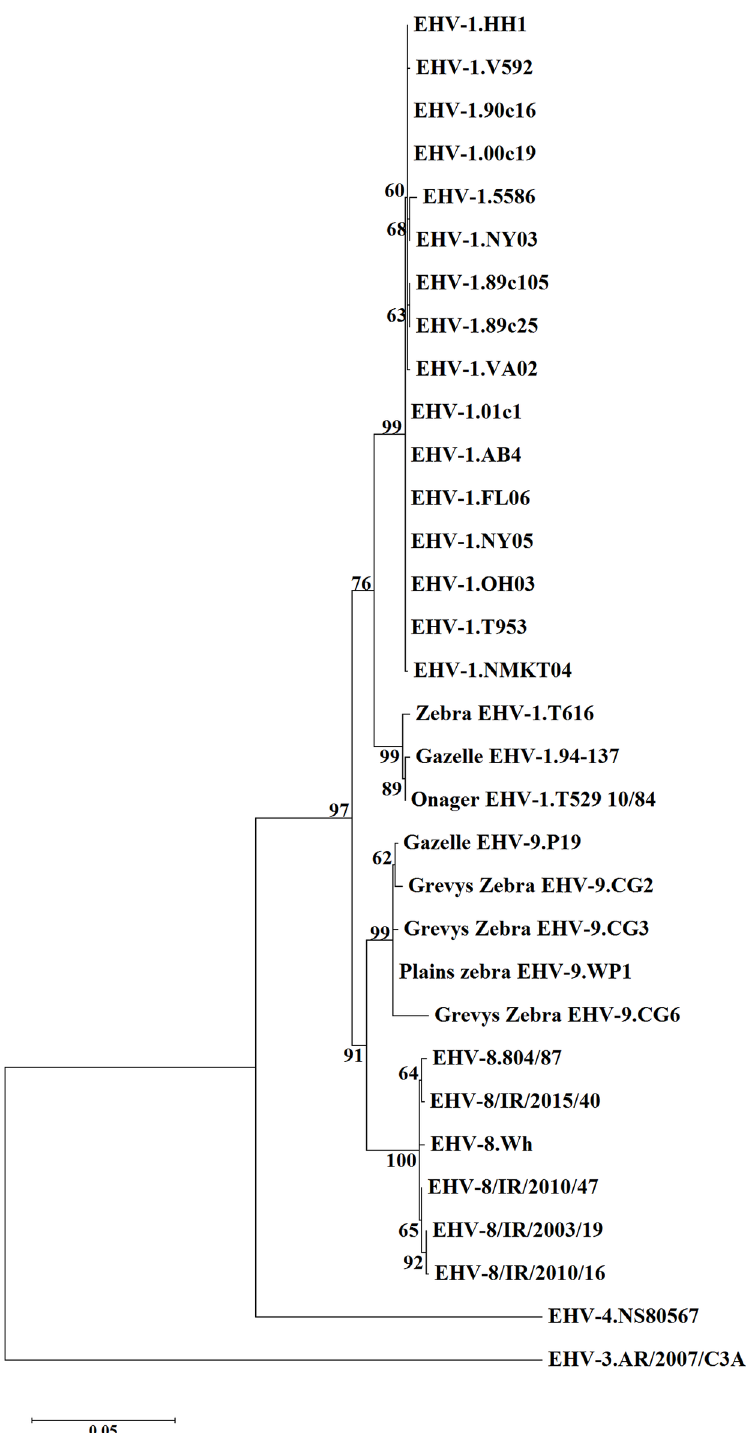
Fig 1. Maximum likelihood phylogenetic tree of ORF30 amino acid sequences based on the JTT matrix-based model. Details of the sequences are in S1 Table of the Supporting Information. The scale bar represents the number of substitutions per site. Bootstrap values after 1000 replications are indicated at major